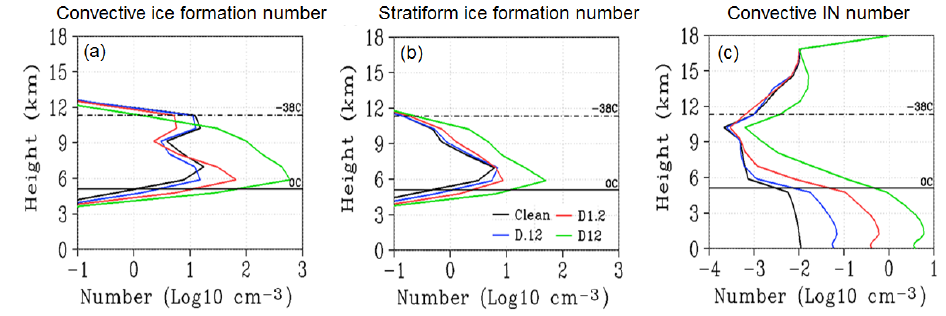
Figure 5. Vertical profile of combined heterogeneous and homogenous ice formation number (Log 10 , cm − 3 ) summed horizontally and over the duration of the simulation for convective (a) and stratiform (b) clouds, respectively. Convective-cloud-averaged and time-averaged vertical profile of residual (nonactivated, in-cloud) IN number concentration (Log 10 , cm − 3 ). Colors represent Clean (black), D.12 (blue), D1.2 (red), and D12 (green) cases,